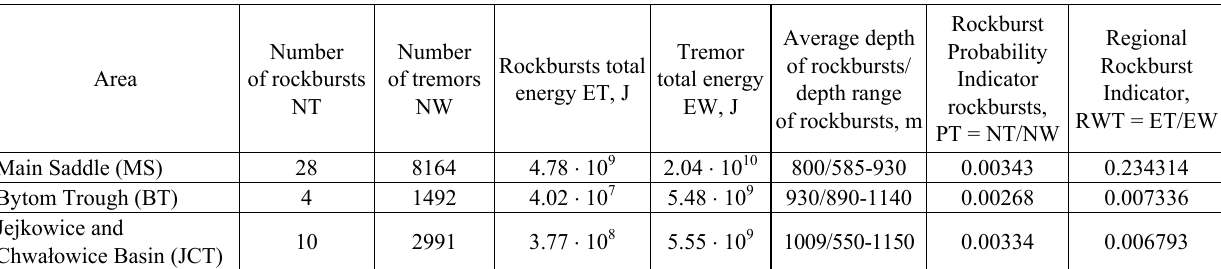
Table 4. List of rockburst indicators that occurred between 2001 and 2015 for structural units of the Upper Silesian Coal